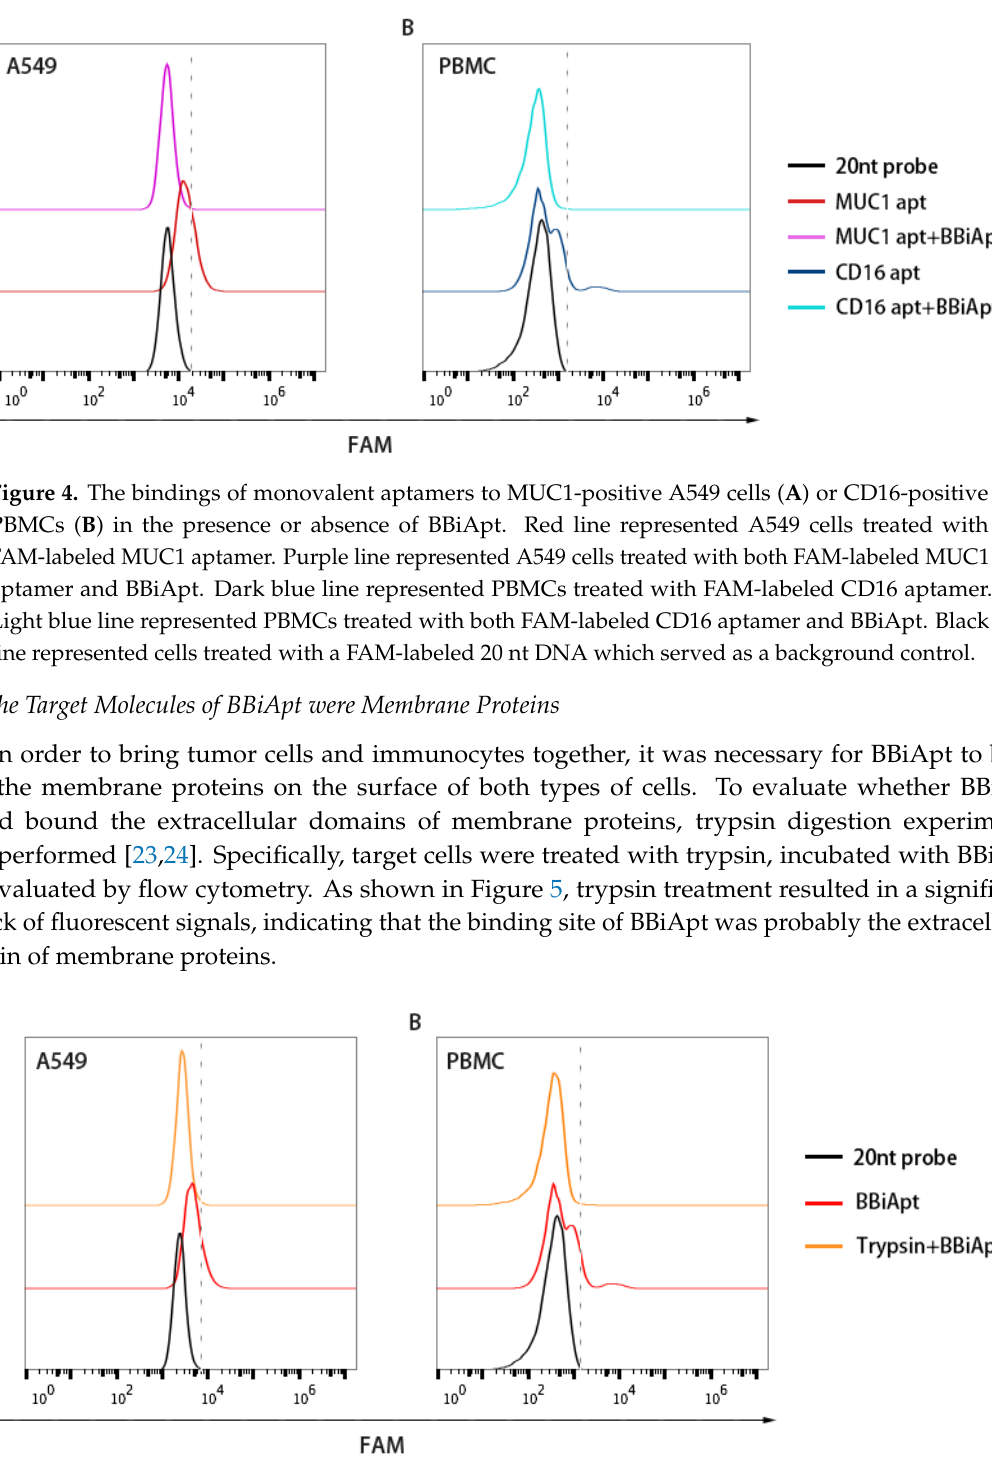
Figure 5. Bindings of BBiApt to A549 cells ( A ) and PBMCs ( B ) after trypsin treatment. A FAM-labeled 20 nt probe that hybridized to the nonfunctional part of BBiApt was utilized to generate fluorescent signal for BBiApt. Red line represented cells treated with BBiApt. Orange line represented cells treated with trypsin for 10 min first, followed by incubation with BBiApt. Black line represented cells treated with the FAM-labeled 20 nt probe which served as a background control.